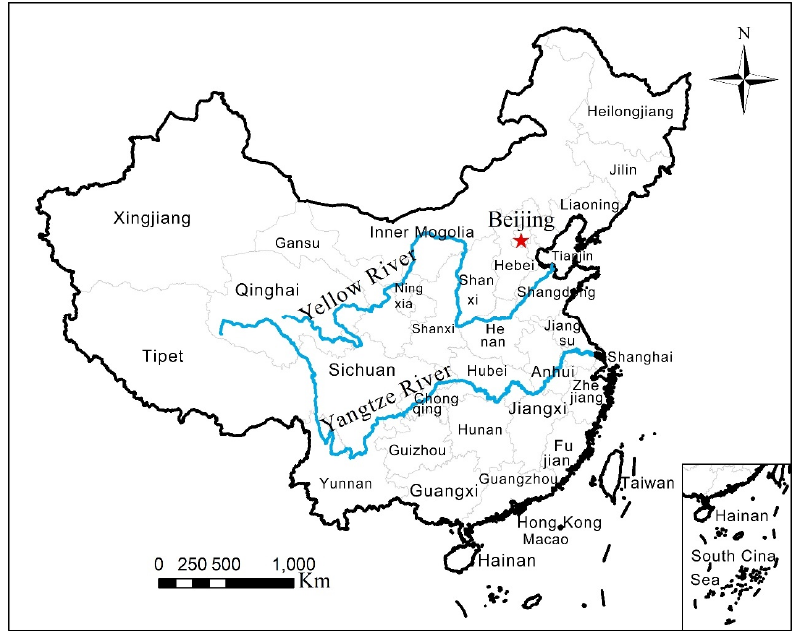
Figure 1. Administrative map of